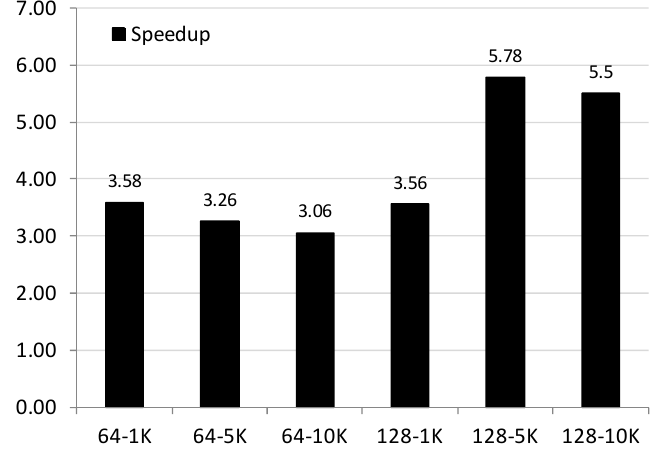
Figure 14. Speedup when comparing CPU and GPU times for Ch130 with respect to different populations (64 and 128) and iterations (1000, 5000, and 10,000).